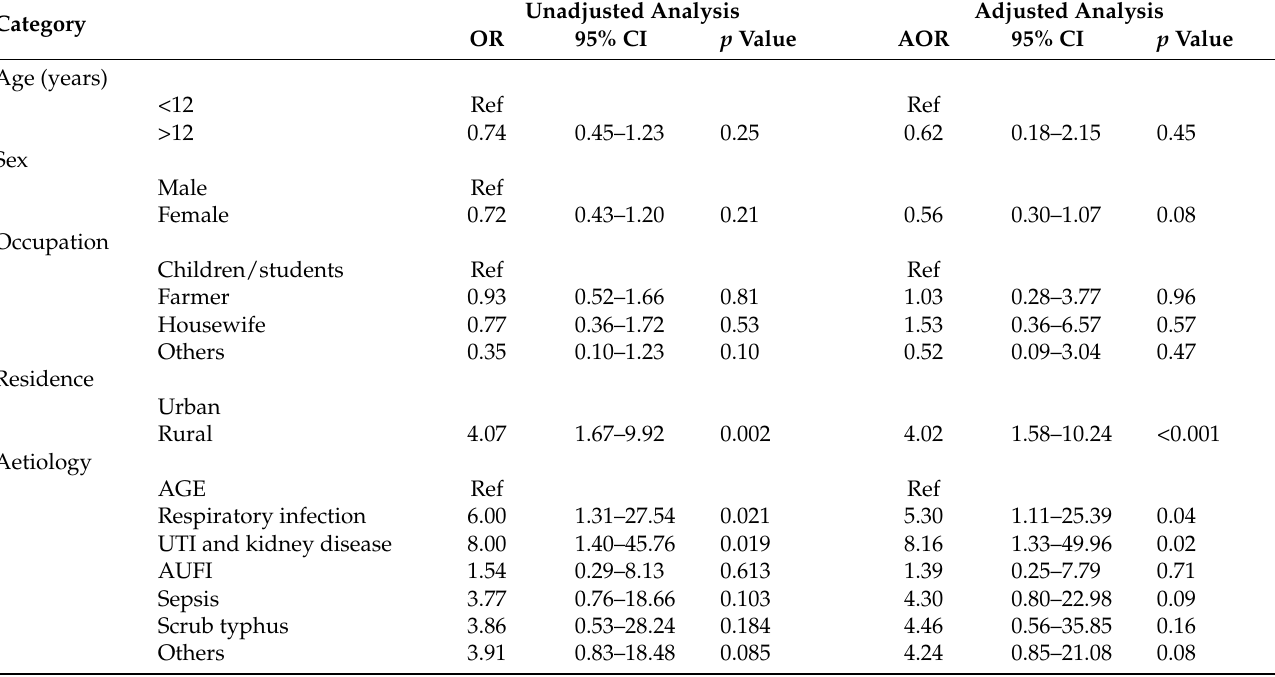
Table 3. Multivariable logistic regression of factors associated with the prolonged fever admissions in Samtse Hospital, Bhutan,